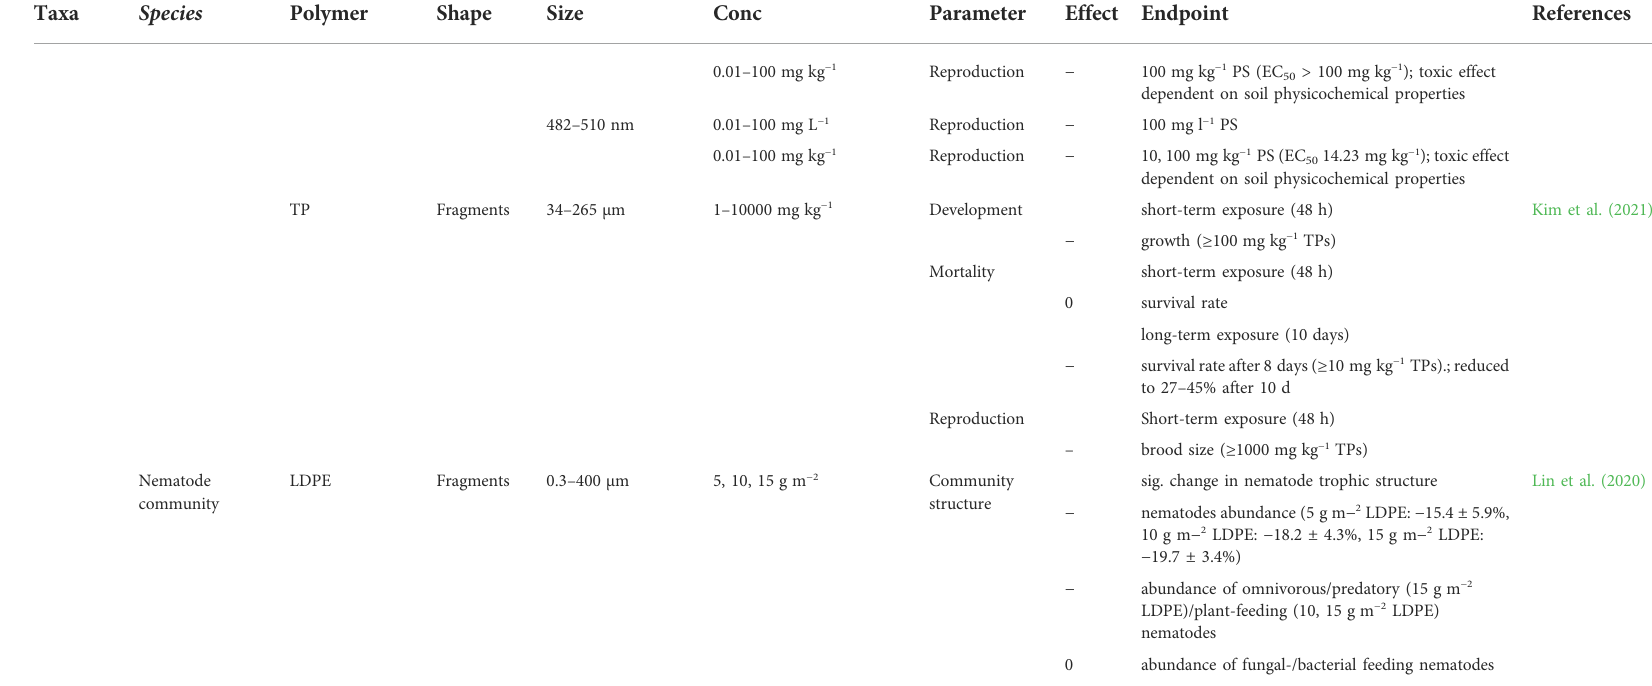
The parameters are listed in alphabetical order. Abbreviations: conc. = concentration, dw = dry weight, fw = fresh weight, i. c.w. = in comparison with, MP = microplastics, not sp. = not speci fi ed, 8-OHdG (indicator for DNA damage) = 8-hydroxy-2 ′ - deoxyguanosine,sig.=signi fi cant.Theconcentrationsoftheappliedmicroplasticarestatedfordrysoilunlessstatedotherwise.0=noeffecton...,+=signi fi canthigher/more,-=signi fi cantlower/fewer.Theparameterdevelopmentappliestothebiomass (fw) unless stated otherwise. The abbreviations of evaluated genes and enzymes are spelled in full in the text above describing the physical effects of microplastics on soil invertebrates. All effects are stated in comparison with the control treatment unless stated